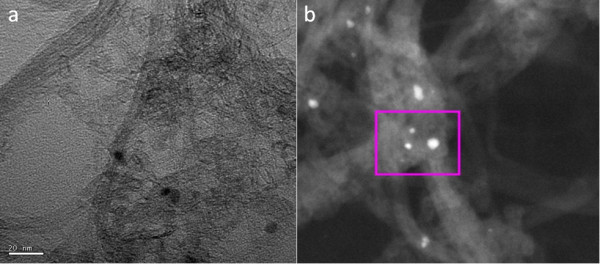
TEM and STEM images of nanotubes. (a) TEM image of the nanotubes; dark spots (impurities). (b) STEM image; evidence of Fe content (inset).